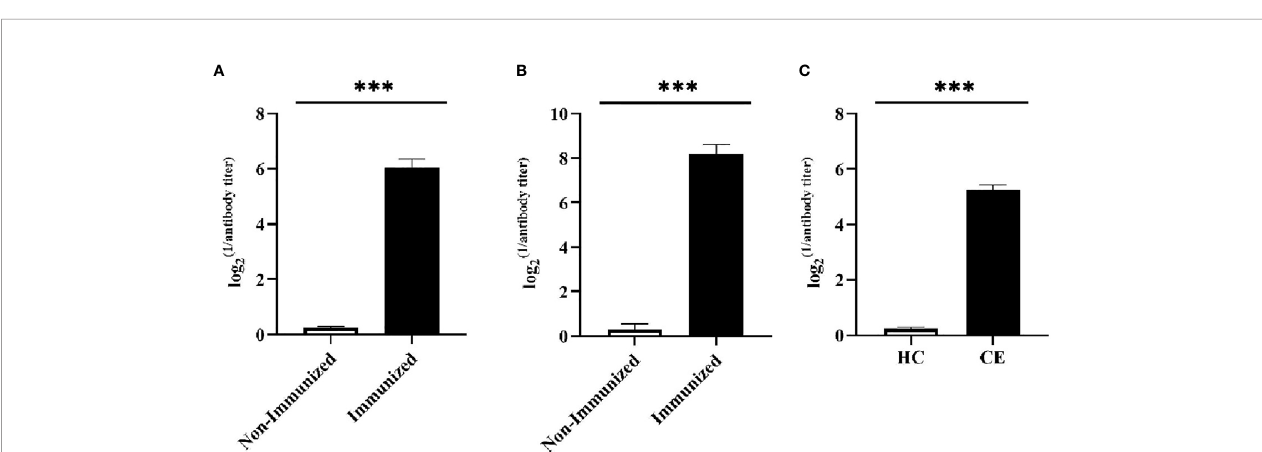
FIGURE 7 | The speci fi c humoral immunity was tested by ELISA. The humoral immunity was assessed by detecting the secretion of speci fi c antibody. (A) After the mice were vaccinated by intranasally dripping, the serum antibody level was detected by ELISA. It was found that the serum antibody level of mice in Immunized group was signi fi cantly higher than that in Non-immunized group. (B) After the mice were vaccinated by subcutaneously injected, the serum antibody level was detected by ELISA. It was found that the serum antibody level of mice in Immunized group was signi fi cantly higher than that in Non-immunized group. (C) The ELISA was used to detect speci fi c antibody in the blood plasma of CE and HC groups, and it was found that the level of speci fi c antibody in the CE group was signi fi cantly higher than that in the HC group. (*** P <